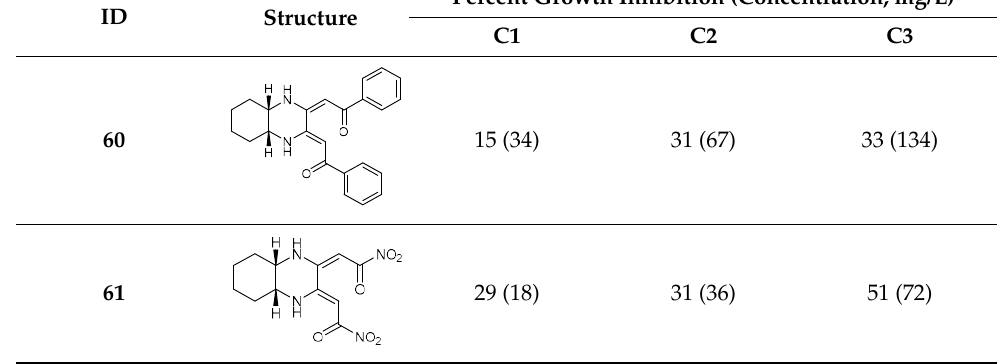
Table 7. Cont. ID Structure